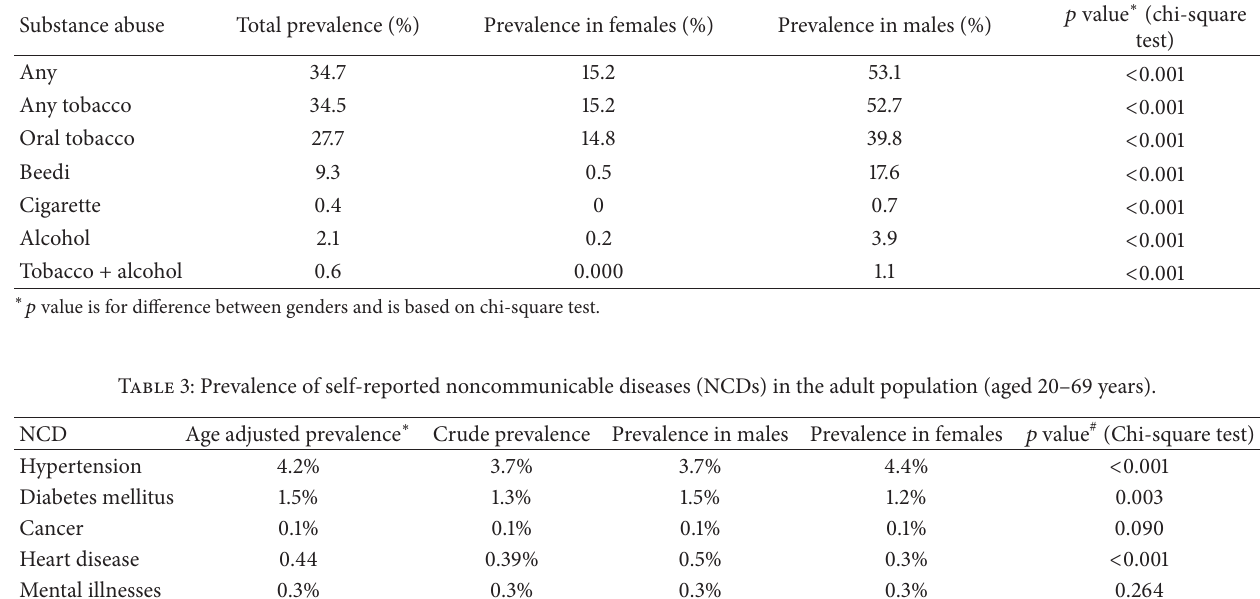
For crude prevalence between males and females.